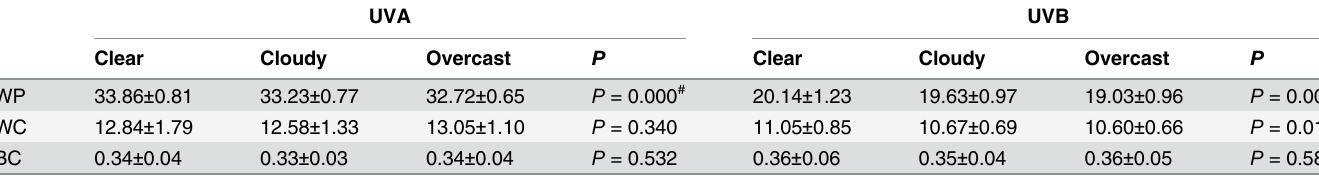
Table 2. Ultraviolet light transmission through clothing in different types of weather (%).